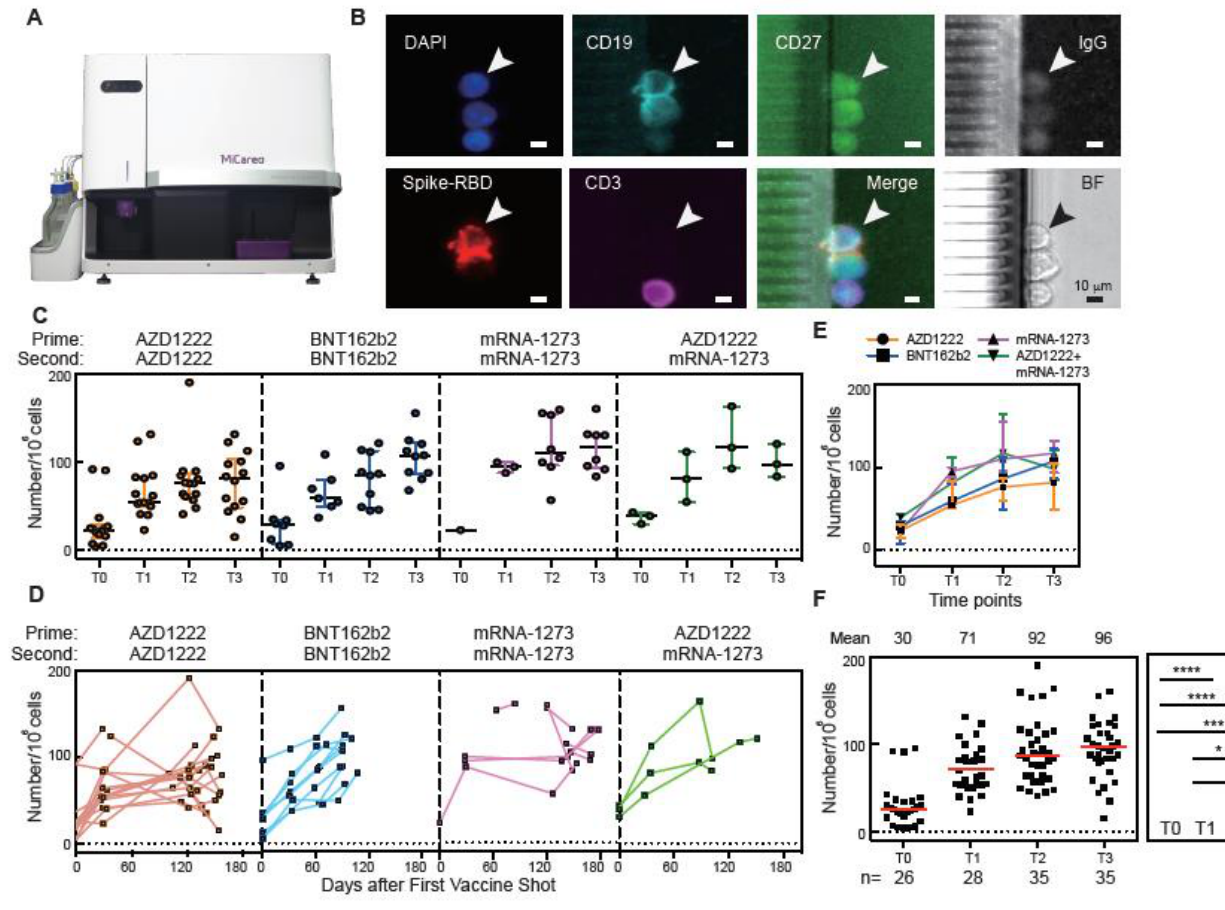
Figure 2. Spike-RBD-specific memory B cells induced by SARS-CoV-2 vaccination over time. ( A ) The MiSelect R II System for spike-RBD cell isolation and analysis. ( B ) Example images of the automated reagent labeling and fluorescence imaging performed by the MiSelect R II. ( C – E ) CD19+, CD27+, IgG+, spike-RBD+, CD3- specific MBCs in PBMC samples from vaccinated subjects over time. ( F ) Total number of spike-RBD-specific MBCs in PBMC samples from all vaccinated subjects for each time point. The number of subjects (n) was shown below the graph. The error bar indicates the median and interquartile range. Statistics were calculated using the non-parametric Mann – Whitney test. The dotted line indicated the limit of detection (LOD) for the assay. * p < 0.05; ** p < 0.01; **** p < 0.0001; ns, no significant difference.